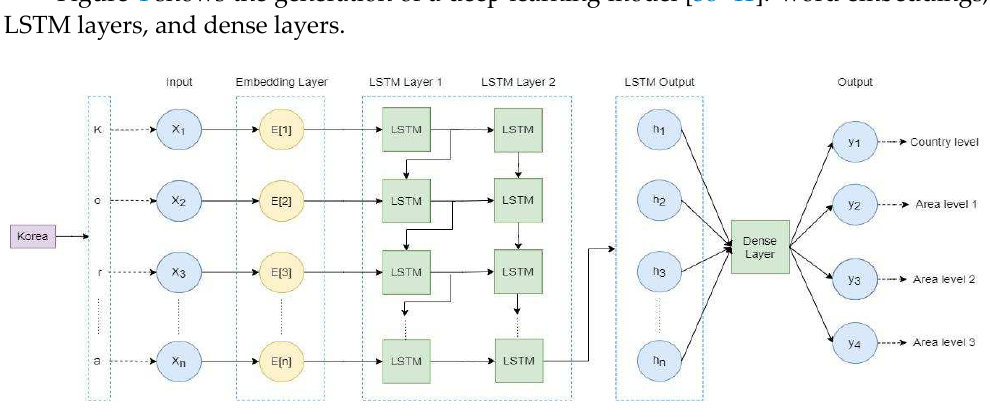
Table 2. Sample training dataset.